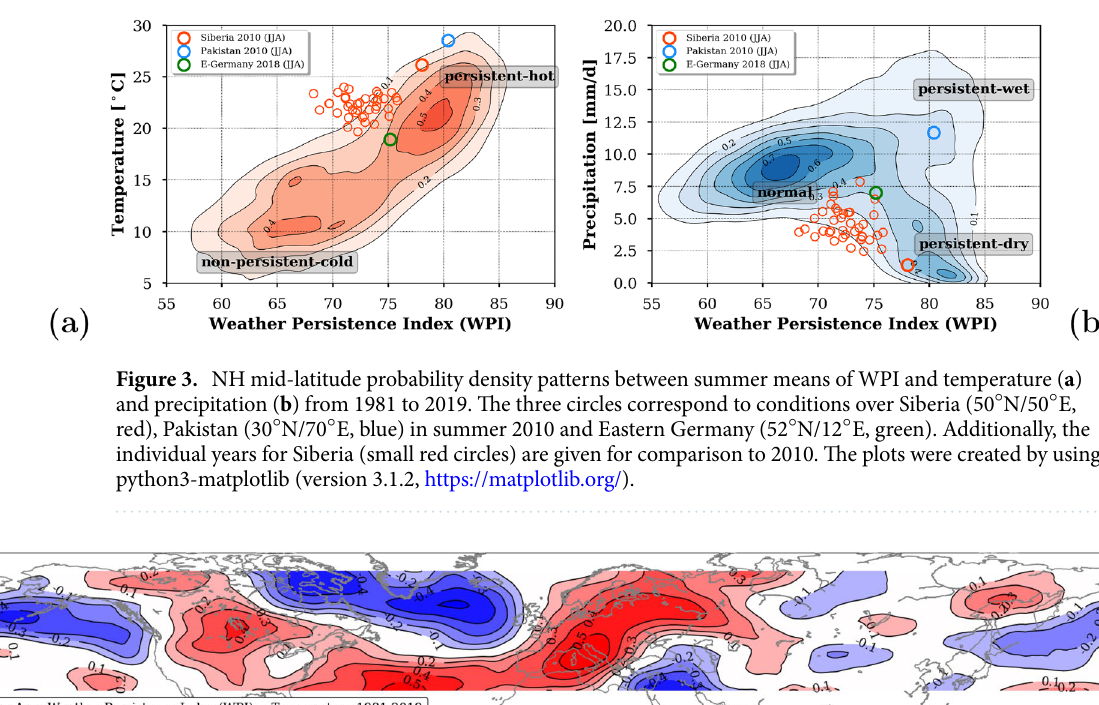
Figure 4. Correlation patterns between Jun–Aug means of weather persistence index (WPI) and temperature ( a ) and precipitation ( b ) from 1981 to 2019: positive (red, violet) and negative (blue, orange). The map were created by using python3-mpltoolkits.basemap (version 1.2.1, https:// matpl otlib. org/ basem